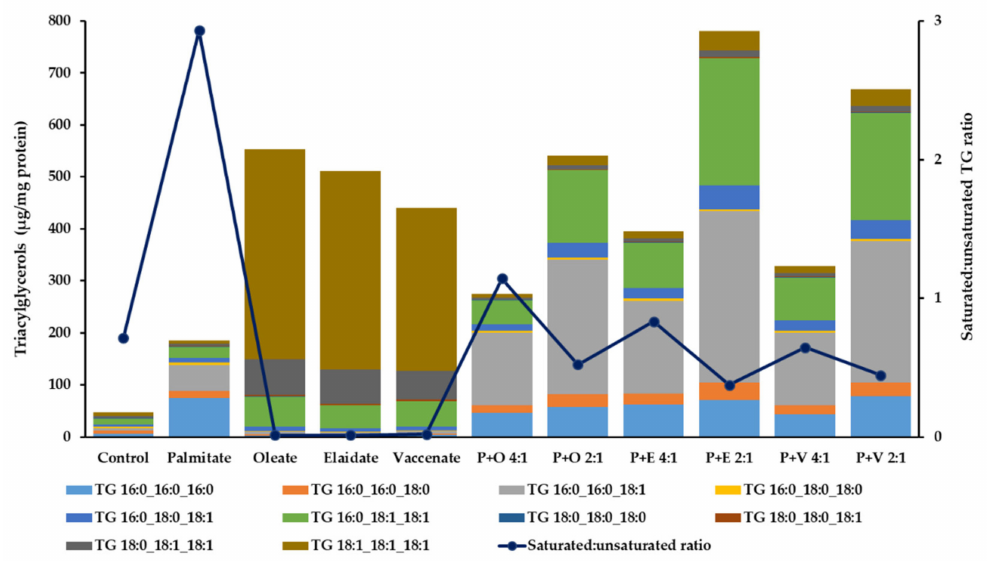
Figure 5. Triglyceride content of hepatoma cells in lipotoxicity. Cells were treated with BSA- conjugated palmitate, oleate, elaidate or vaccenate (800 µ M) or with palmitate (800 µ M) and oleate, elaidate or vaccenate at 4:1 or 2:1 molar ratio (200 or 400 µ M) at 70–80% confluence for 8 h. The amount of relevant triglycerides (columns) was measured by LC-MS/MS. Data were normalized to the total protein content of the samples and are shown as the mean values of four independent experiments (see the mean and S.D. values in Table S6). The ratio of the mean values for